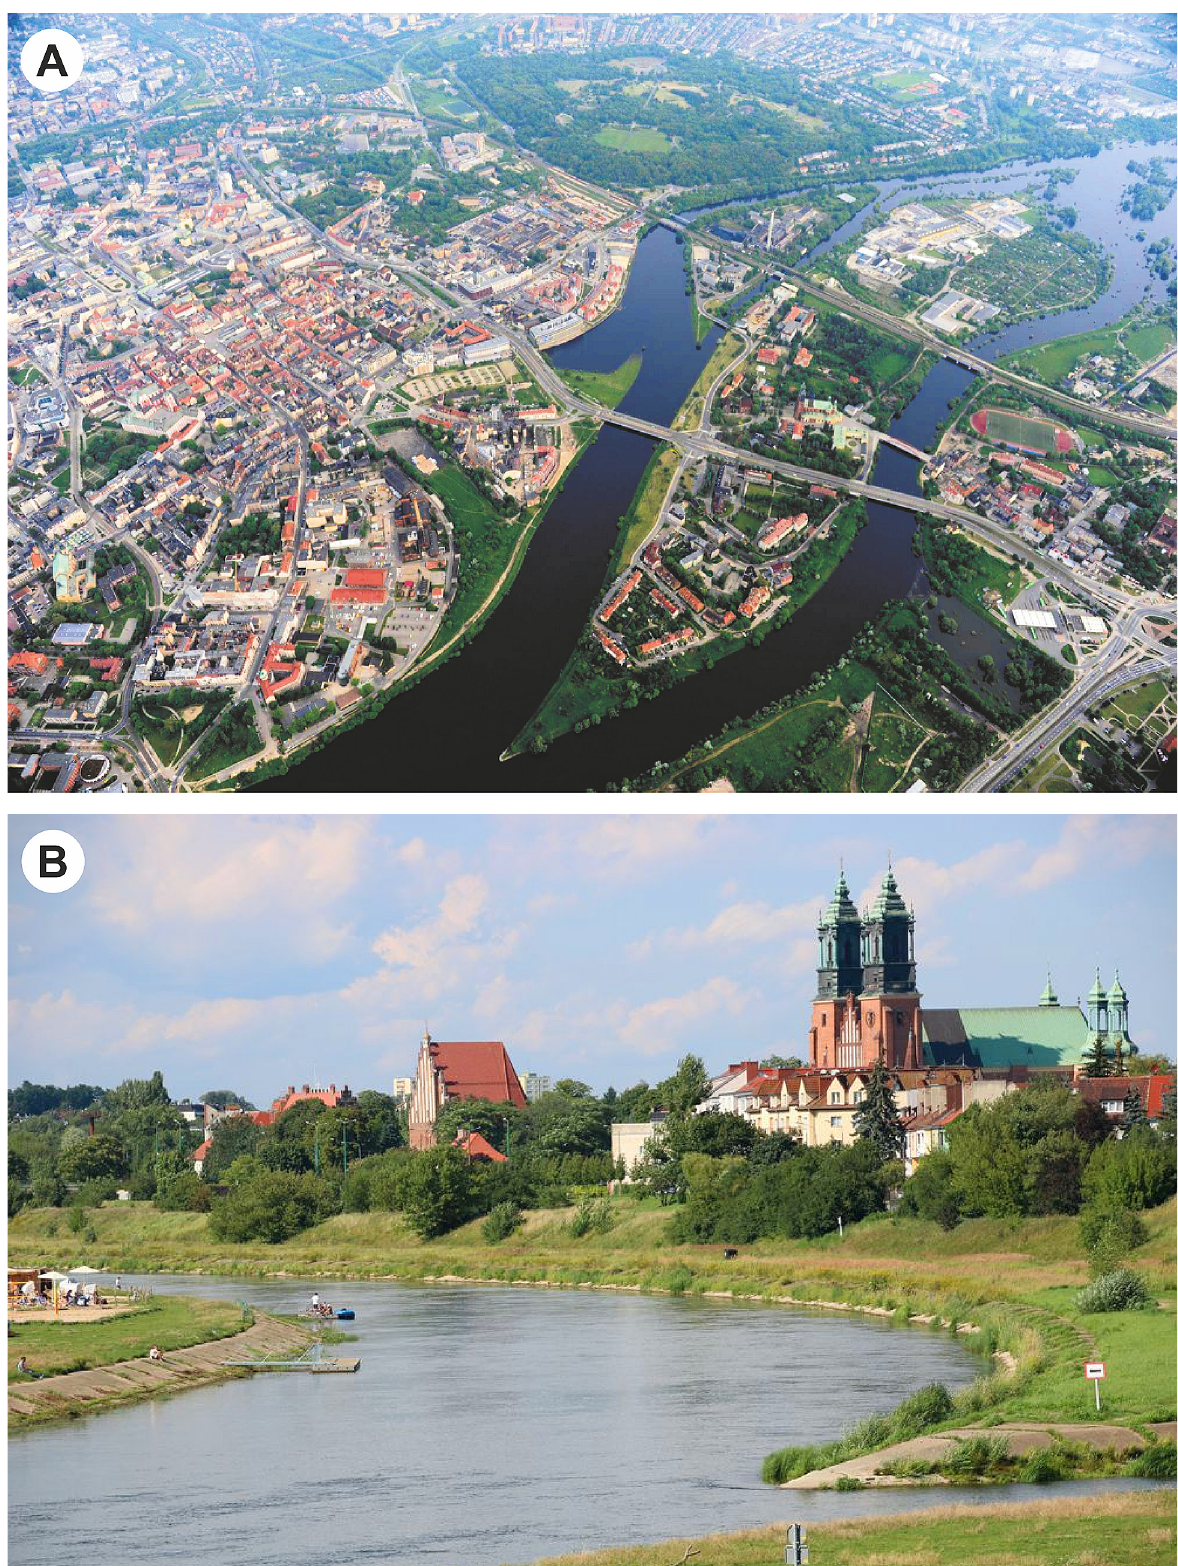
Fig. 14. Proposed urban geosite of the Poznań section of the Warta River